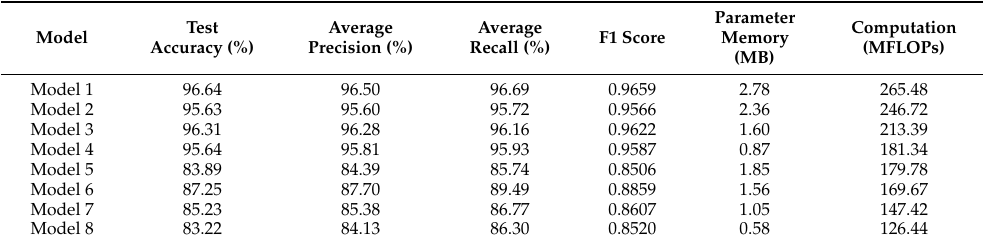
Table 2. Modified model parameters and